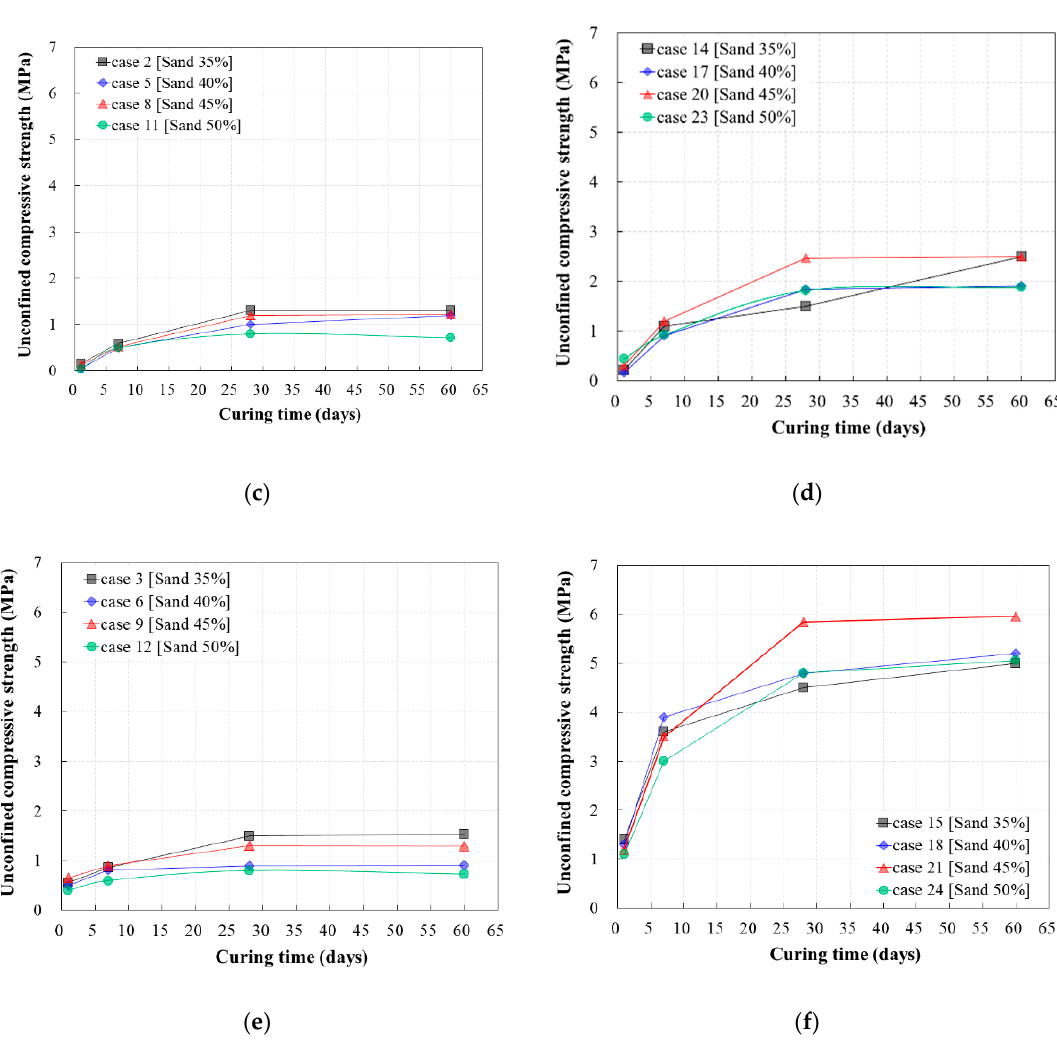
Figure 9. Unconfined compressive strength versus mixing ratio between WPSA and fly ash: ( a ) WPSA/FA = 1:0 (cement 5%); ( b ) WPSA/FA = 1:0 (cement 10%); ( c ) WPSA/FA = 1:1 (cement 5%); ( d ) WPSA/FA = 1:1 (cement 10%); ( e ) WPSA/FA = 0:1 (cement 5%); ( f ) WPSA/FA = 0:1 (cement 10%).